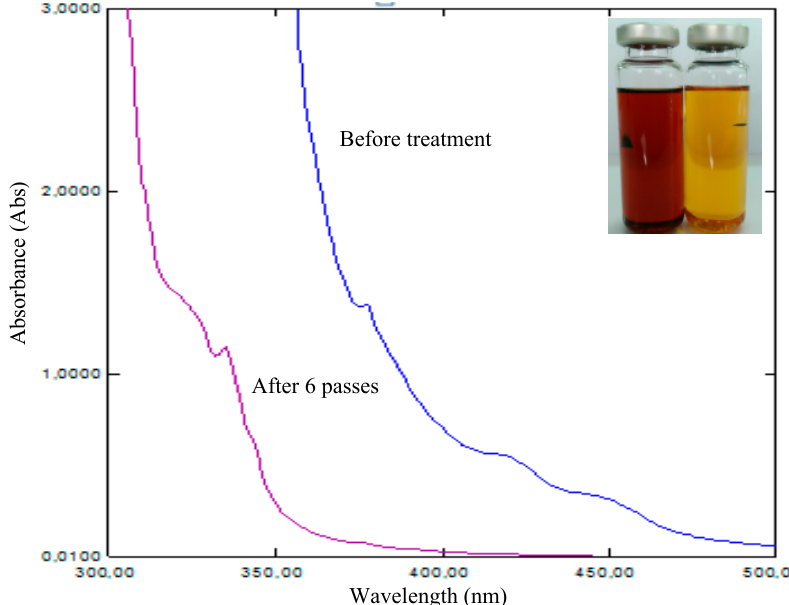
Figure 7. Spectral curves of acidic oil and purified oil. Inset: Change in oil color with six passes.